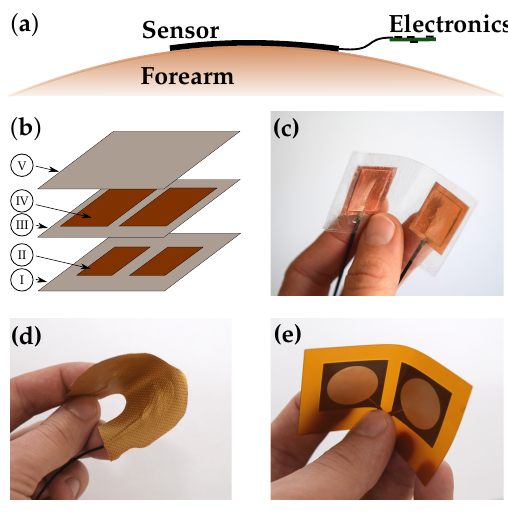
Figure 3. ( a ) Adaptation of the flexible sensor to the human forearm anatomy; ( b ) structure of the multilayer construct ((I) dielectric 1; (II) sensor areas; (III) dielectric 3; (IV) shielding; and (V) dielectric); ( c ) copper sensor (Sensor 1); ( d ) textile sensor (Sensors 2 and 3); and ( e ) flex sensor (Sensors